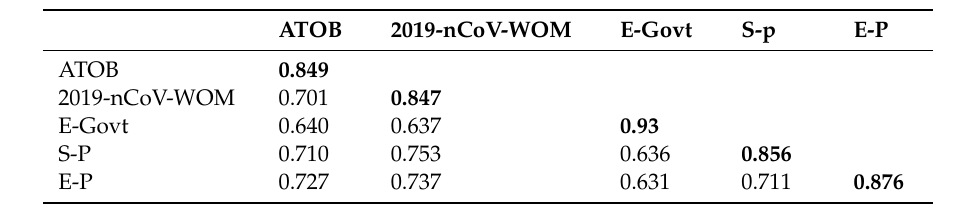
Table 4. Discriminant